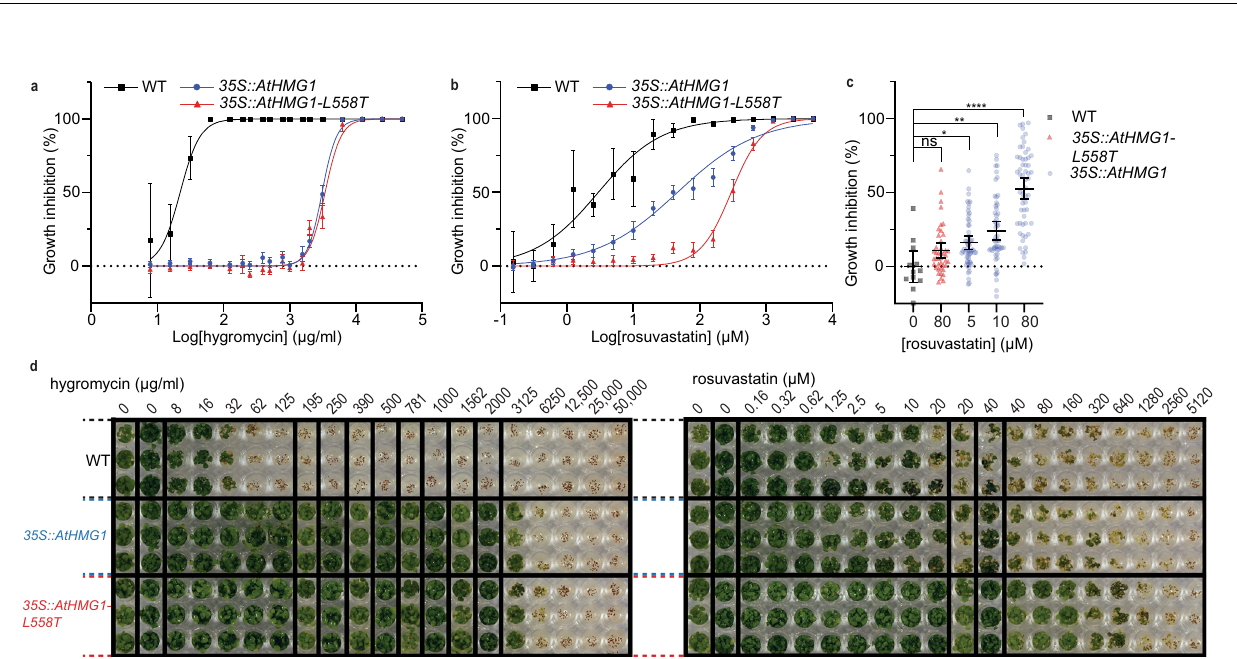
Fig. 5 | A mutation found in a statin biosynthetic cluster confers statin resis- tance in vitro. a The hydrophobic pocket in AtHMG1 delineated by labelled resi- dues (blue sticks) with pitavastatin (magenta sticks) bound, illustrating L558 proximity to the hydrophobic ring of statins. b AtHMG1 with the L558T mutation (grey bar) in comparison to wild-type (black bar) retained activity in vitro in the presence of statins: rosuvastatin (Ro.), pravastatin (Pr.), simvastatin (Si.),